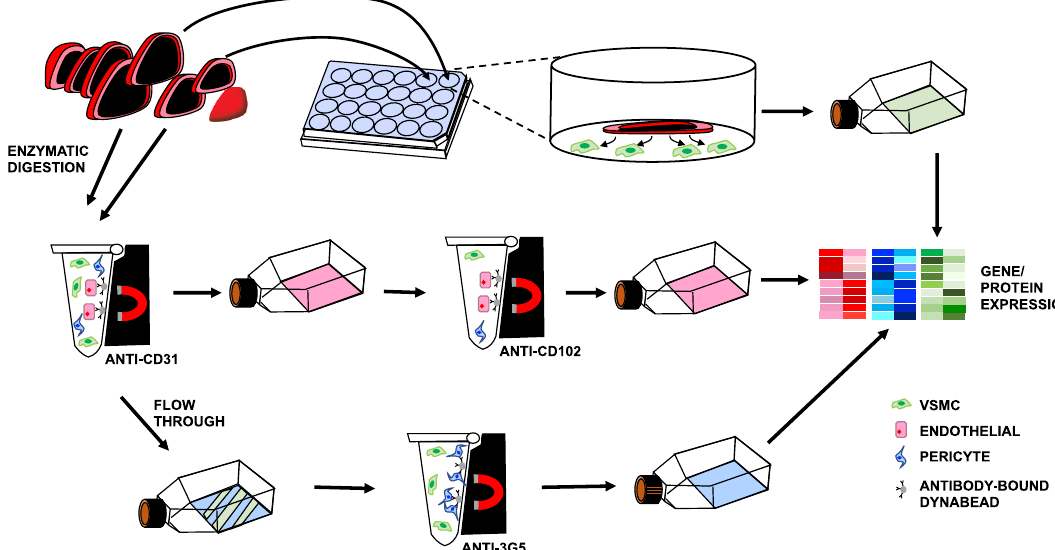
Figure 1. Heart EC, PC, and VSMC isolation protocol. Schematic representation of the isolation and culture process used to generate EC, PC, and VSMC concurrently from mouse hearts. Hearts are isolated and 4 apical slices are taken from each heart to generate SMCs by explant.The remaining heart tissue is digested to generate a single cell suspension. EC cultures are generated by magnetically selecting cells with CD31- conjugated Dynabeads, culturing until confluent and then again magnetically selecting using CD102-conjugated Dynabeads. PCs are isolated by culturing CD31-negative cells until confluent and then selecting using 3G5 ganglioside-conjugated